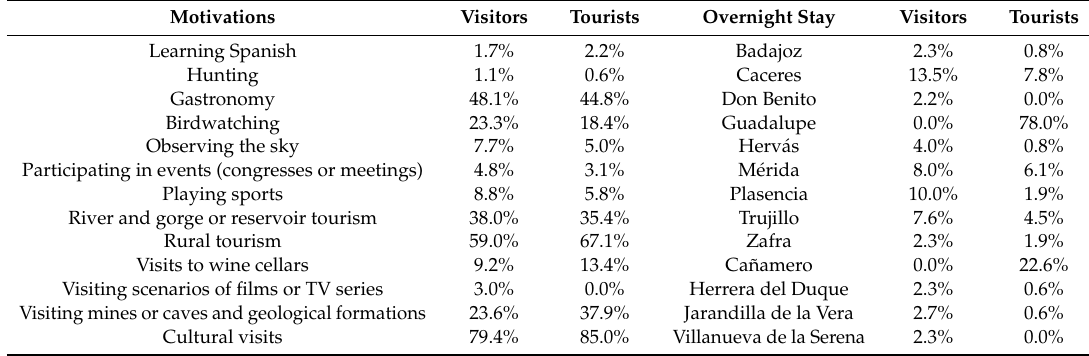
Table 5. Motivations and overnight stay locations of visitors to the geopark—visitors vs